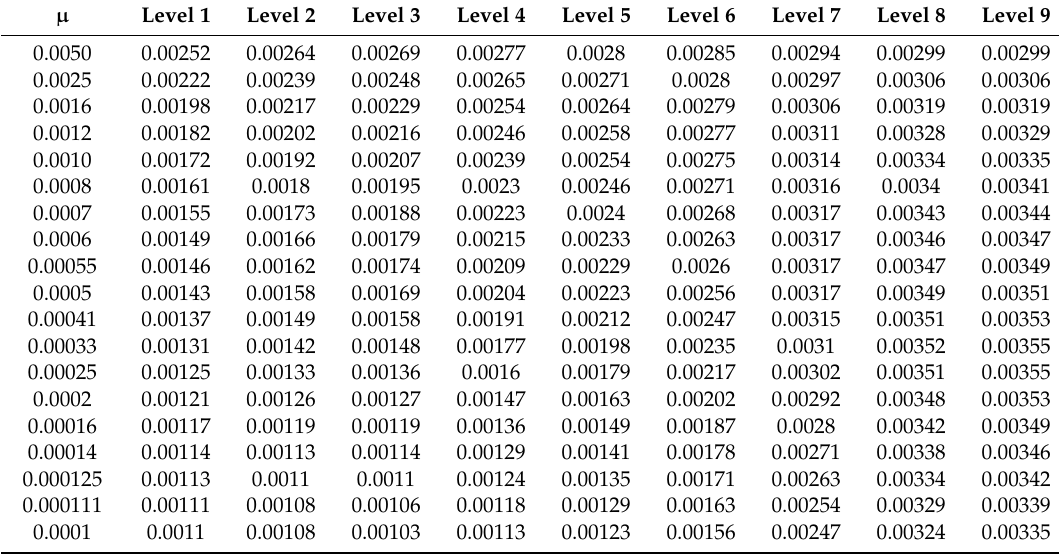
Table 2. Kinetic energy values when only upper wall is